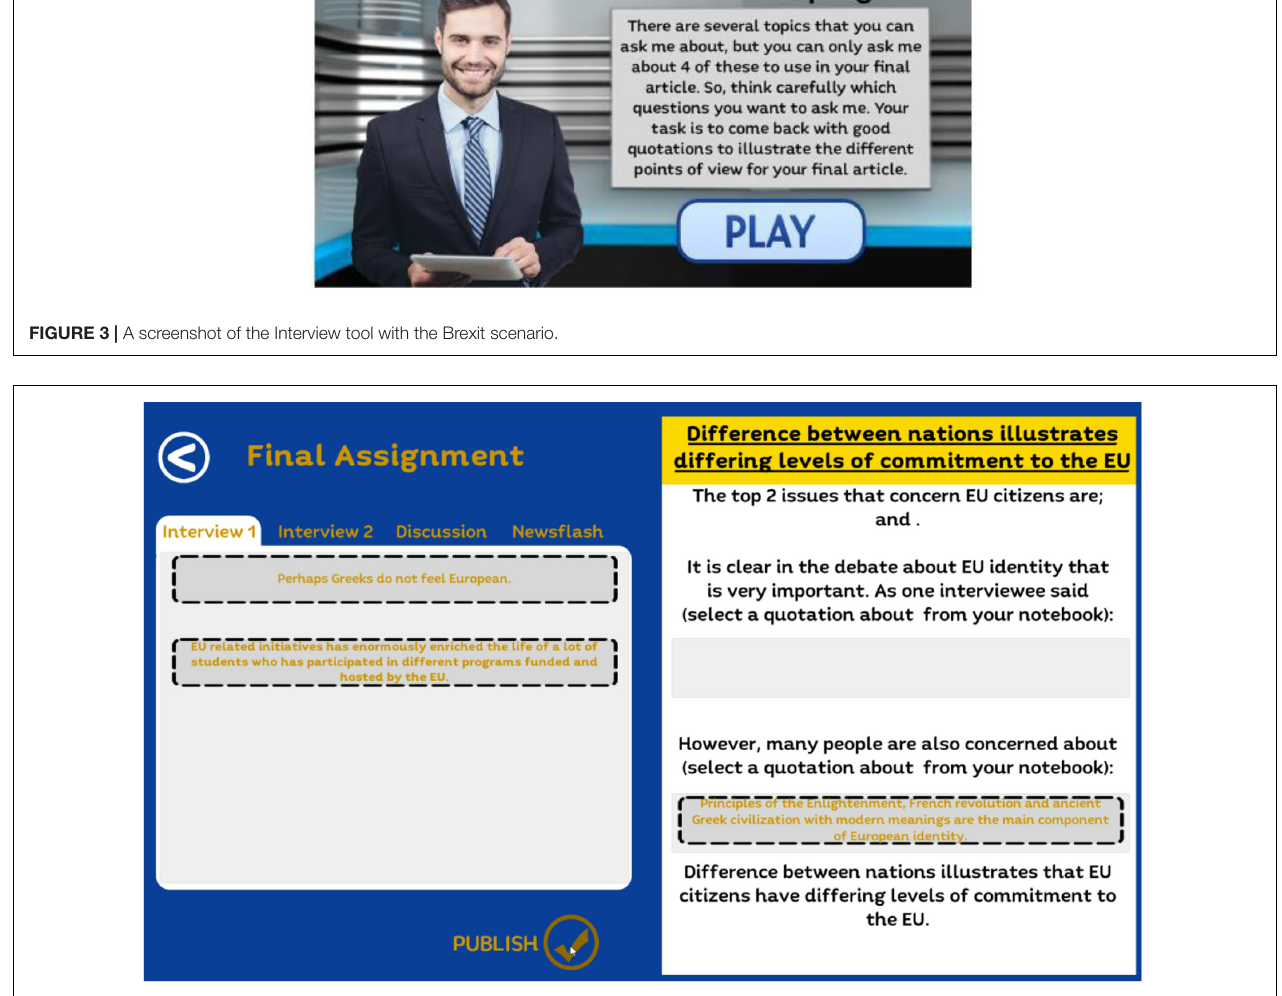
FIGURE 4 | Final assignment and game